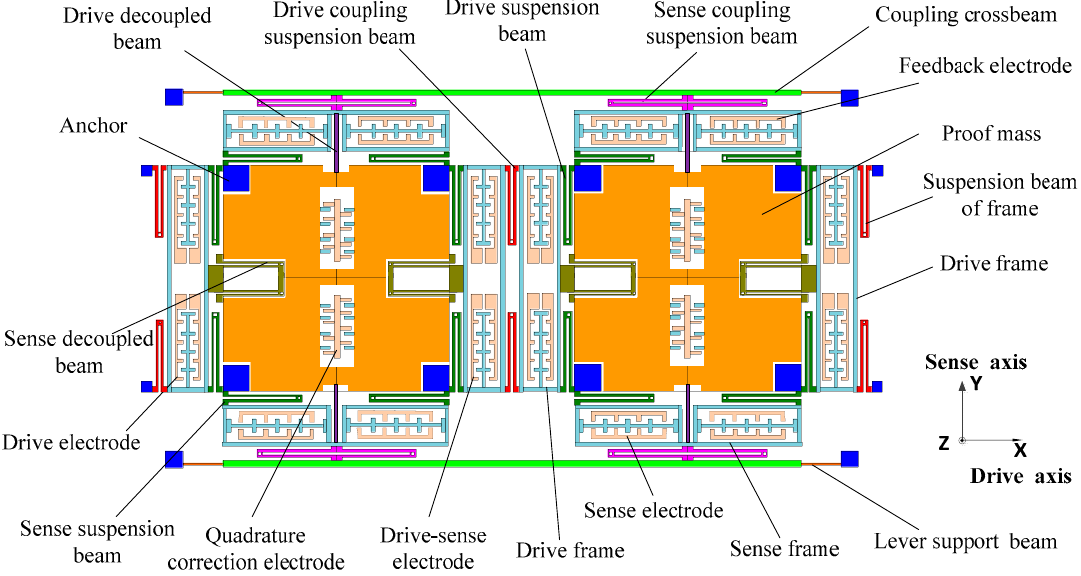
Figure 1. Improved DDMG structural scheme.